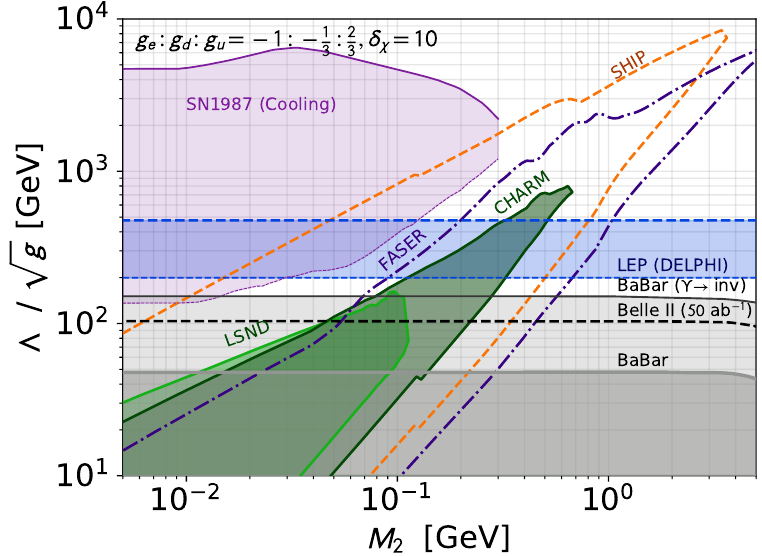
p g in the case